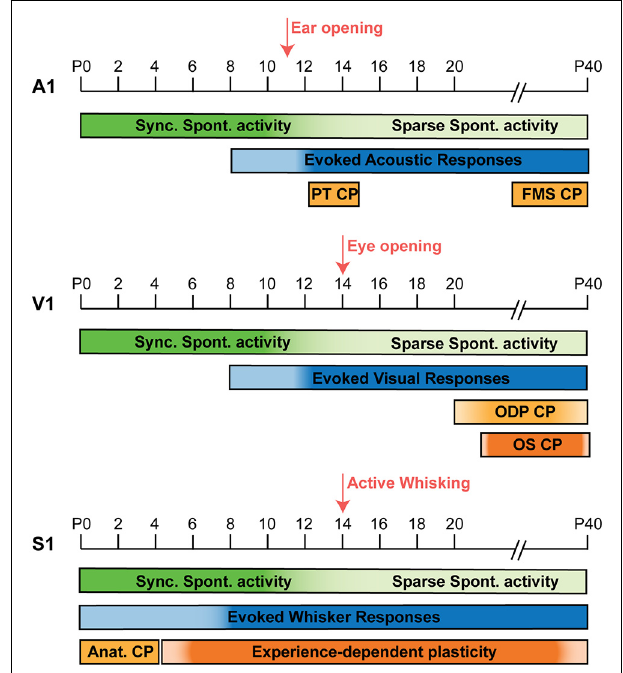
FIGURE 1 | Timeline comparison of cortical activity development in A1, V1, and S1. Development of cortical activity in mice from P0 to P40 in A1, V1, and S1. In the three areas, synchronized spontaneous activity is present during the first postnatal week, but it desynchronizes through the second postnatal week in A1 (Babola et al., 2018; Meng et al., 2020); V1 (Rochefort et al., 2009; Ackman et al., 2012; Siegel et al., 2012), and S1 (Golshani et al., 2009; Che et al., 2018). In A1 (top panel), the onset of evoked sensory activity takes place by the end of the first postnatal week and it becomes more prominent upon ear opening at P11 (Anthwal and Thompson, 2016; Makarov et al., 2021). Two auditory critical periods for pure tones (PT CP; Barkat et al., 2011) and Frequency modulated sweeps (FMS CP; Bhumika et al., 2020) take place shortly after, P12–15 and P31–38 respectively. In V1 (middle panel), evoked visual responses start by the end of the first postnatal week and become more reliable by the second postnatal week (Colonnese et al., 2010), around the time of eye opening ( ∼ P14). The critical period for ocular dominance (ODP CP) takes place between P21 and P35 (Hensch, 2005; Espinosa and Stryker, 2012) and an orientation selectivity (OS) CP has been shown in google-reared mice between P28 and P49 (Yoshida et al., 2012). In S1 (bottom panel), passive whisker stimulation can trigger evoked responses from birth (Anton-Bolanos et al., 2019), but these responses become more reliable around P6–8 (Colonnese et al., 2010) and active whisking onset occurs around P14 (Landers and Philip Zeigler, 2006). An early anatomical CP is observed in S1 from P0 to P4, capable of altering barrel formation and thalamocortical innervation (Durham and Woolsey, 1984; Lee et al., 2009). While throughout life, different paradigms of sensory deprivation can induce discrete forms experience-dependent plasticity in particular